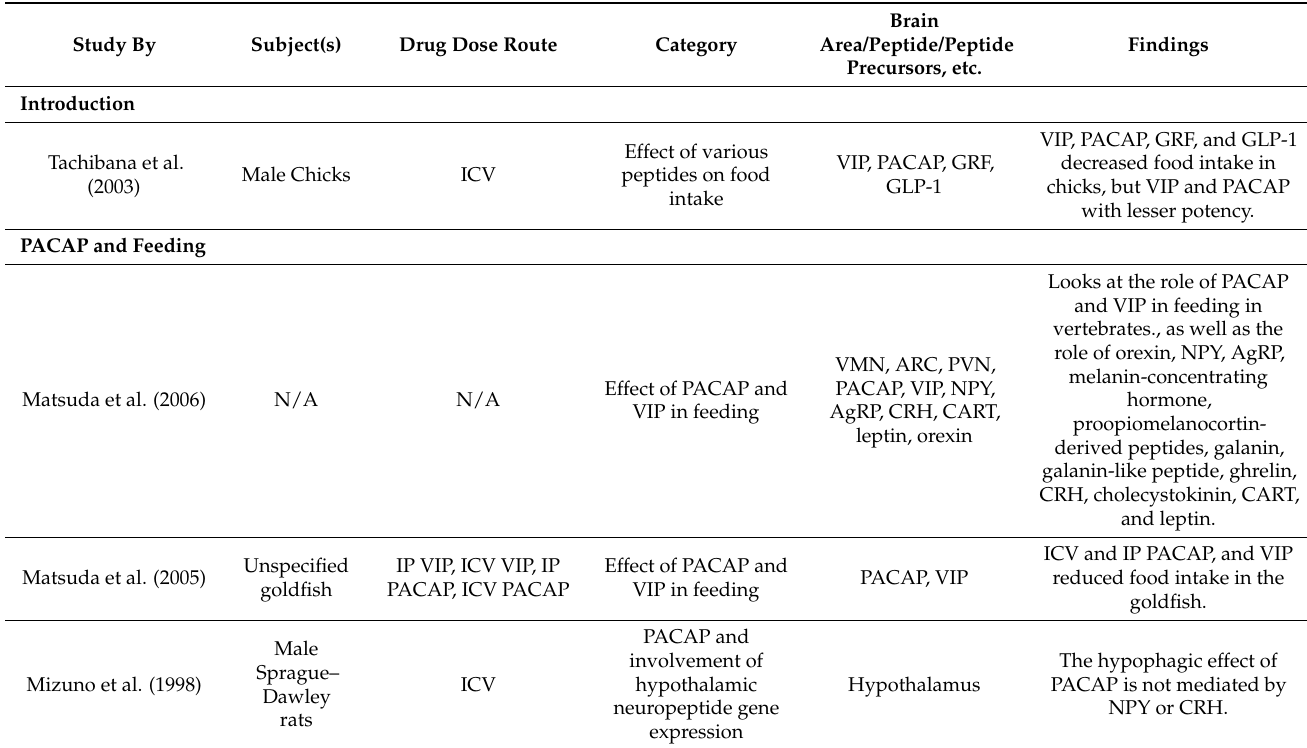
Table 1. Summary of all the studies included in this review with subjects used, drug dose and route of administration, and their